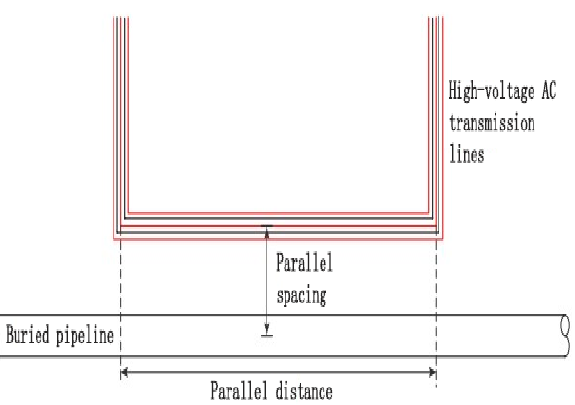
The parallel spacing is the distance between the transmission conductor at the ver- tical projection to the ground and the pipeline at the vertical projection from the ground (Figure 12).